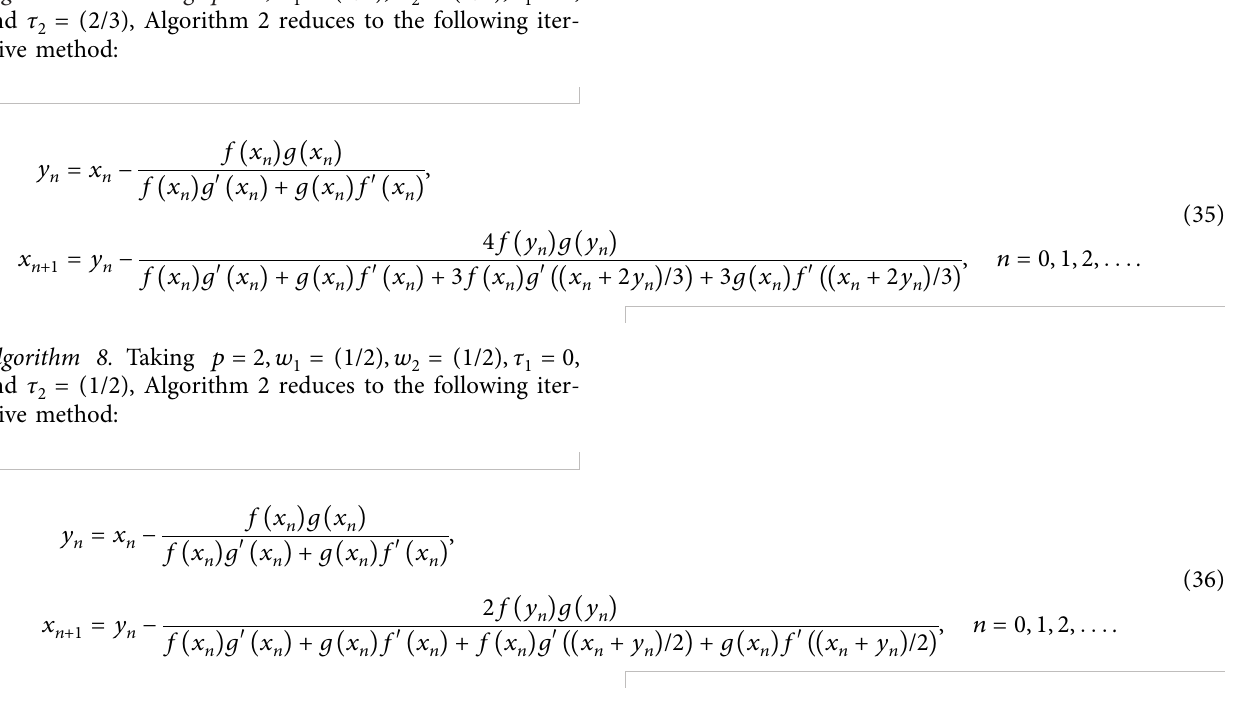
Algorithm 7. Taking p � 2 , w